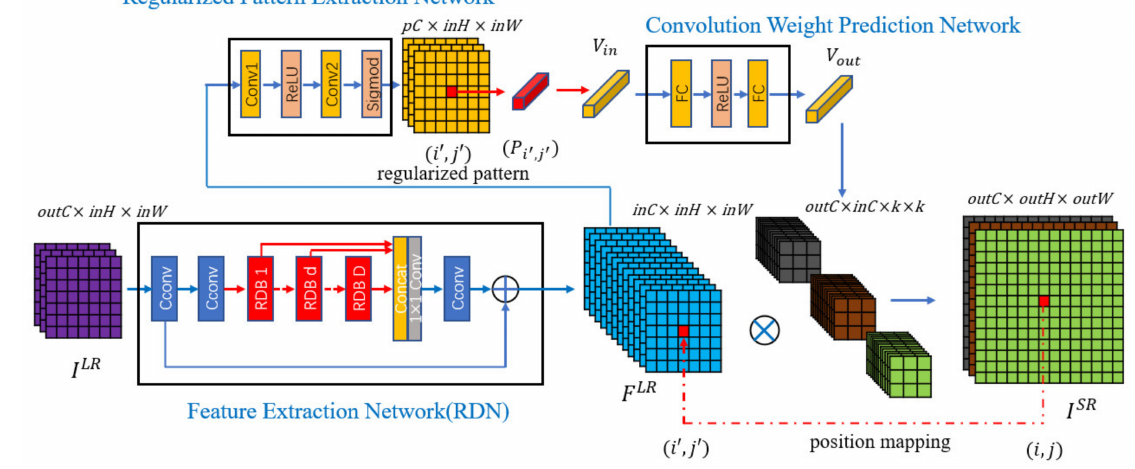
Figure 4. An overview of the network structure of the proposed SR